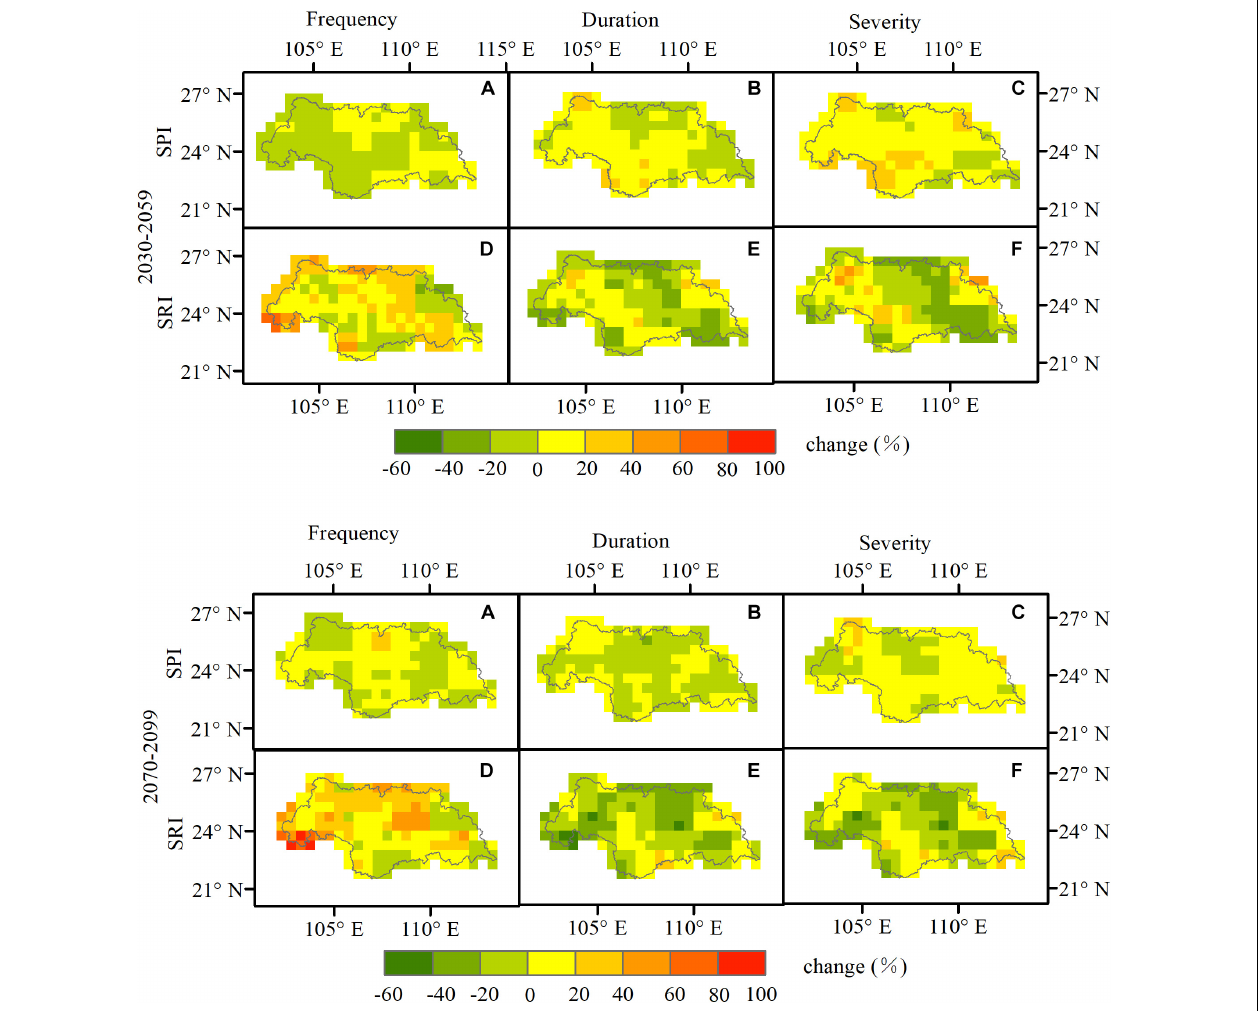
FIGURE 4 | Changes in the characteristics of meteorological droughts for the SPI between the future periods (2030–2059 and 2070–2099) and the historical period (1971–2000): (A) frequency, (B) duration, (C) severity, and changes in the characteristics of hydrological droughts for the SRI between the future periods (2030–2059 and 2070–2099) and the historical period (1971–2000): (D) frequency, (E) duration, and (F)